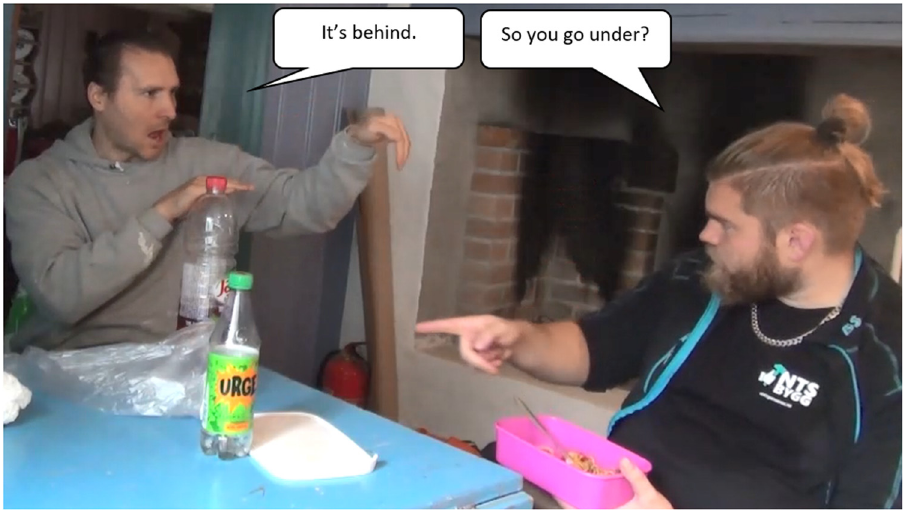
Figure 7: Candidate understanding o ff er ( Abe to the right signing UNDER ) overlapping with Ben signing BEHIND ) . ( Lines 14 and 15.